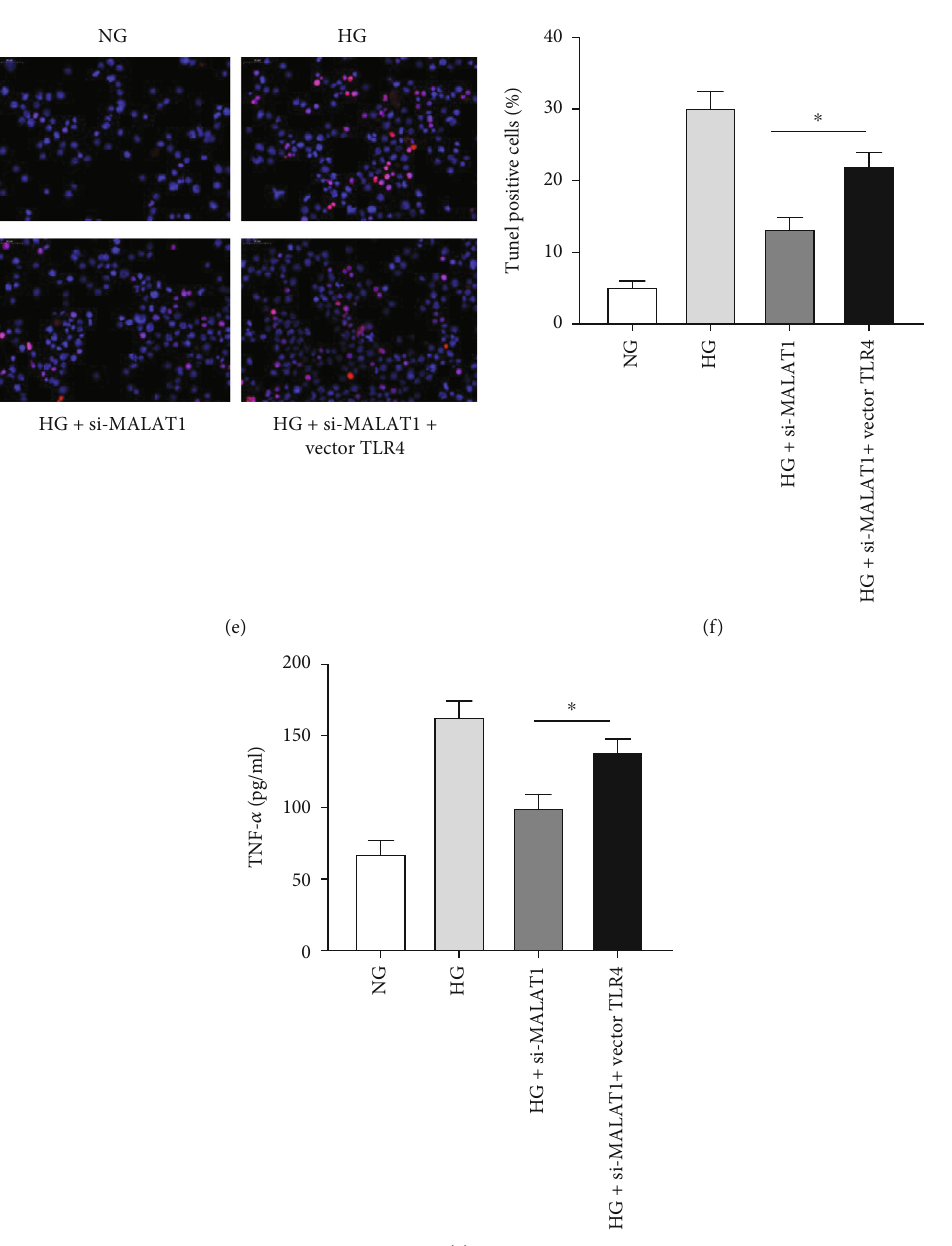
Figure 4: miR-15b-5p negatively regulates TLR4, and MALAT1 regulates TLR4 expression via miR-15b-5p. (a) TLR4 complementary sequences of wild-type (Wt) and mutant-type (Mt) TLR4 are shown with the miR-15b-5p sequence. (b) The inhibitory e ff ect of miR- 15b-5p on TLR4 3 ′ -UTR in HK-2 cells transfected with TLR4 3 ′ -UTR by Luciferase reporter assay. ∗ p < 0 : 05 versus the mimics NC group. (c) Western blot analysis of TLR4 in HG-stimulated HK-2 cells transfected with miR-15b-5p mimics or mimics NC. (d) Cell viability by CCK-8 assay, (e, f) cell apoptosis by TUNEL assay, and (g) TNF- α levels by ELISA analysis were examined in HG-induced HK-2 cells cotransfected with si-MALAT1 and vector TLR4. ∗ p < 0 : 05 versus HG+si-MALAT1+vector